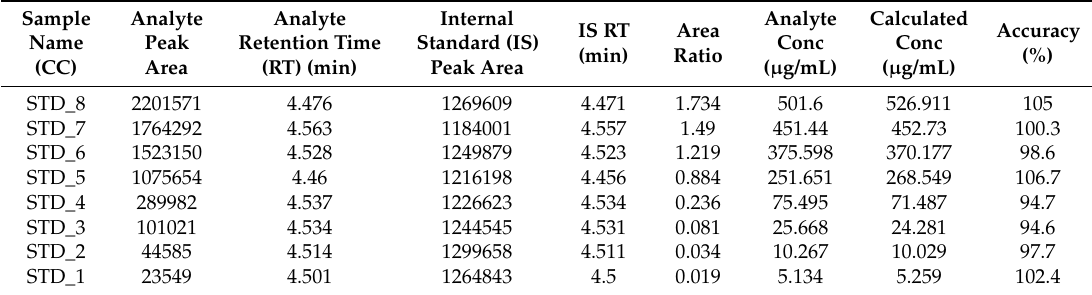
Table 1. Table represents the quantification data of trastuzumab signature peptide (IYPTNGYTR) in human serum batch; calibration curve (CC) extends from 5 µ g/mL to 500 µ g/mL; their corresponding accuracy percentage and R 2 = 0.99 was observed.